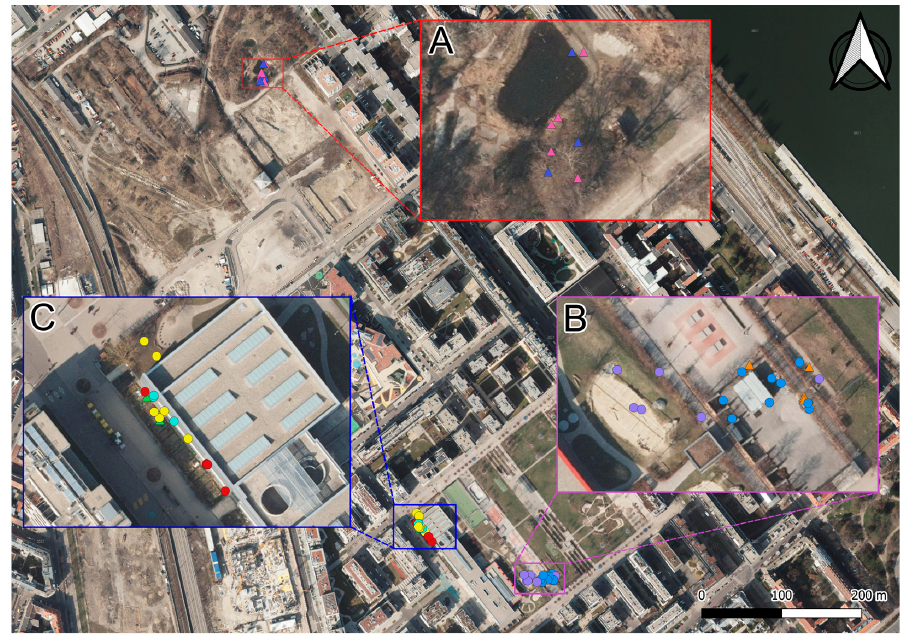
Figure 2. The study area and individual toad locations. The inset ( A ) is a zoomed in view of the Freie Mitte area with the animals K4 (pink rectangle, male) and K1 (blue rectangle, male), inset ( B ) shows the main area close to the spawning area with the animals K3 (orange rectangle, male), K5 (blue dot, male) and K8 (purple dot, female) and inset ( C ) the area behind the school in some small gardens with the animals K2 (green rectangle, male), K6 (red dot, male), K7 (yellow dot, female) and K9 (cyan dot, female). Map taken from [48].